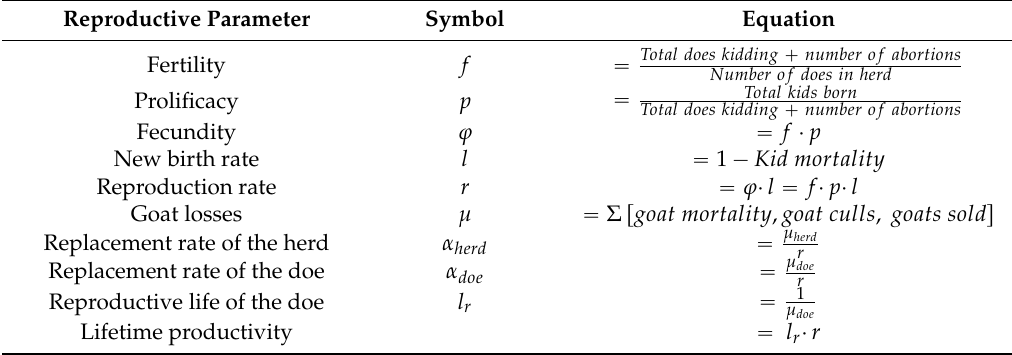
Table 2. The equations for calculating the reproductive parameters, adapted from Pittavino et al. (2014) [11]. Reproductive Parameter Symbol Equation Fertility f “ Total does kidding ` number of abortions Number of does in herd Prolificacy p “ Total kids born Total does kidding ` number of abortions Fecundity ϕ “ f ¨ p New birth rate l “ 1 ´ Kid mortality Reproduction rate r “ ϕ ¨ l “ f ¨ p ¨ l Goat losses µ “ Σ r goat mortality , goat culls , goats sold s Replacement rate of the herd α herd “ µ herd r Replacement rate of the doe α doe “ µ doe r Reproductive life of the doe l r “ 1 µ doe Lifetime productivity “ l r ¨